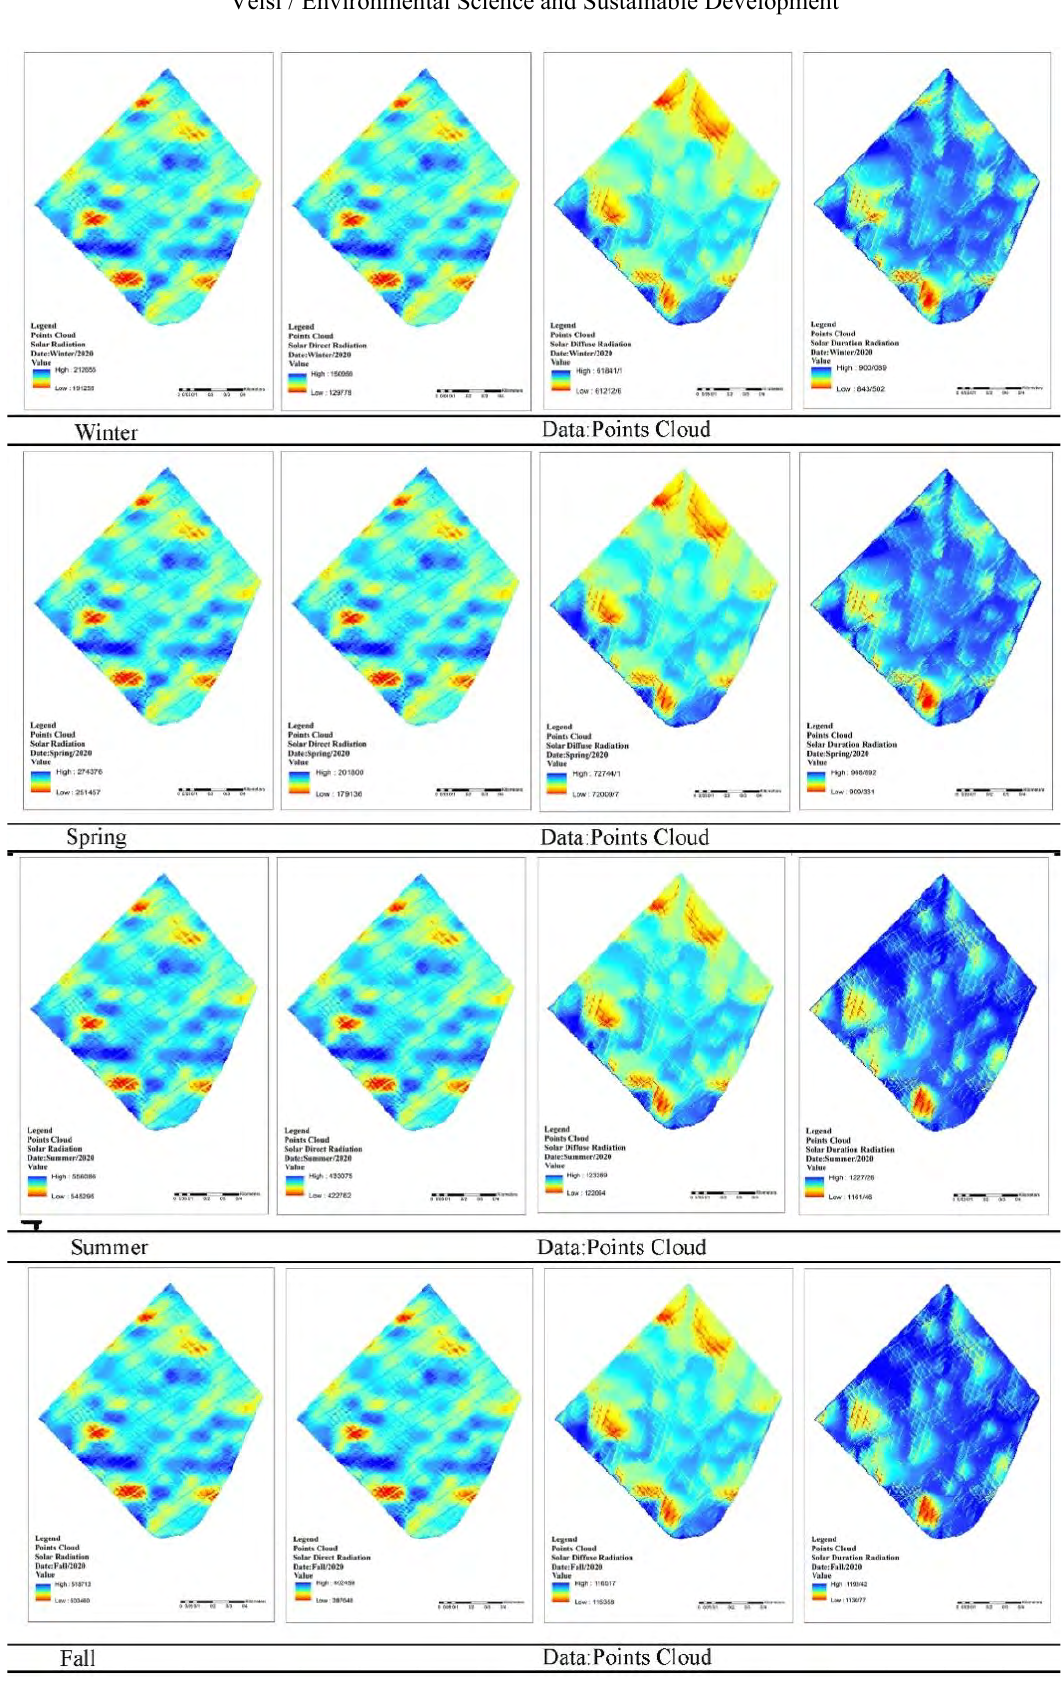
Figure 4. Solar radiation chart in different seasons of the year The diagrams in Figure 4 above show the amount of solar radiation in different seasons of the year based on four variables, each in a particular range based on the radiation amount. Two critical variables in this area, which were significant for this study, were radiation duration and direct